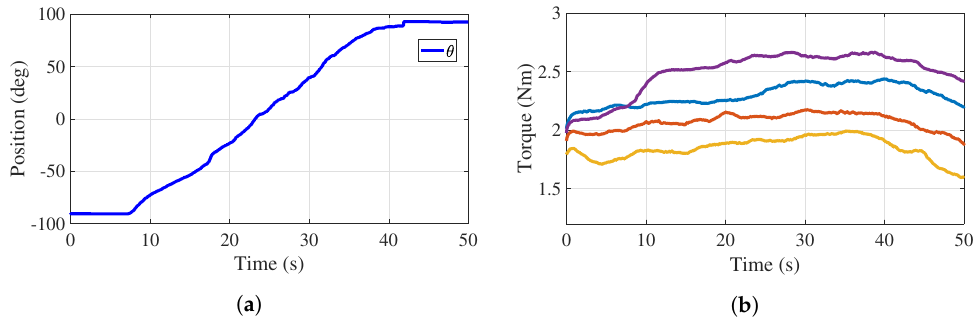
Figure 9. Trajectory tracking and torque adjustment (cables l 1 and l 3 ) with load. ( a ) Handle position. ( b ) Torque behavior.